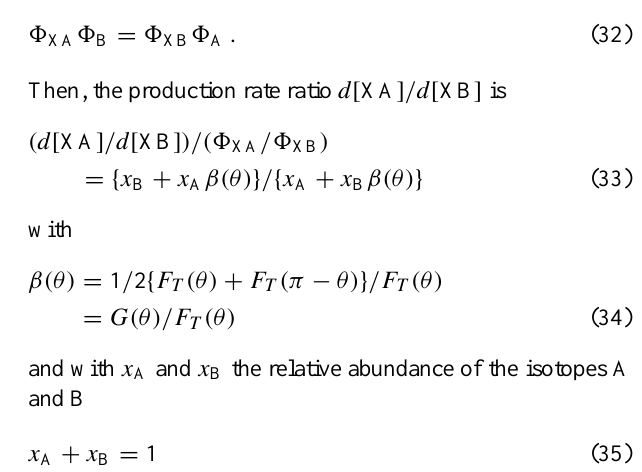
G(θ) 6= F T (θ) , an isotopic fractionation as a function of the scat-